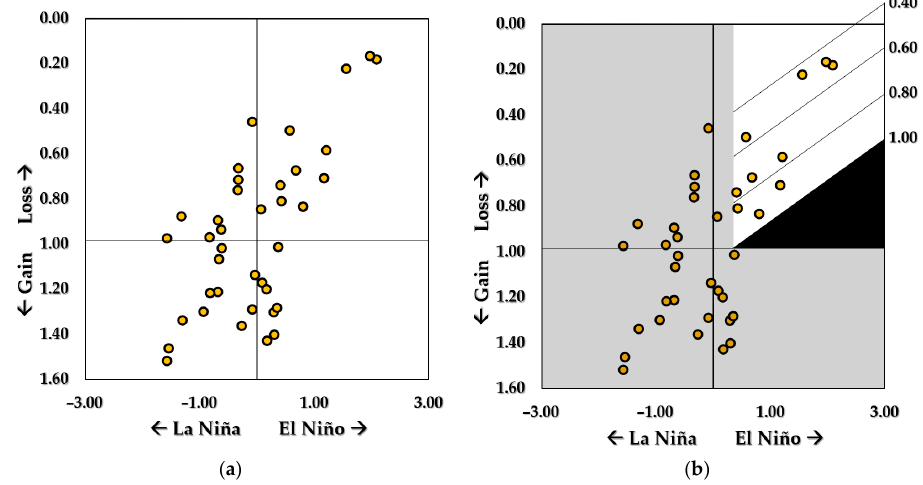
Figure 3. Developed payout scheme for insurance product. ( a ) Scatterplot of ENSO conditions and oca yield (in terms of AEY); ( b ) A graphical approximation of the proposed payout scheme. The black triangle represents the coverage provided by the product.